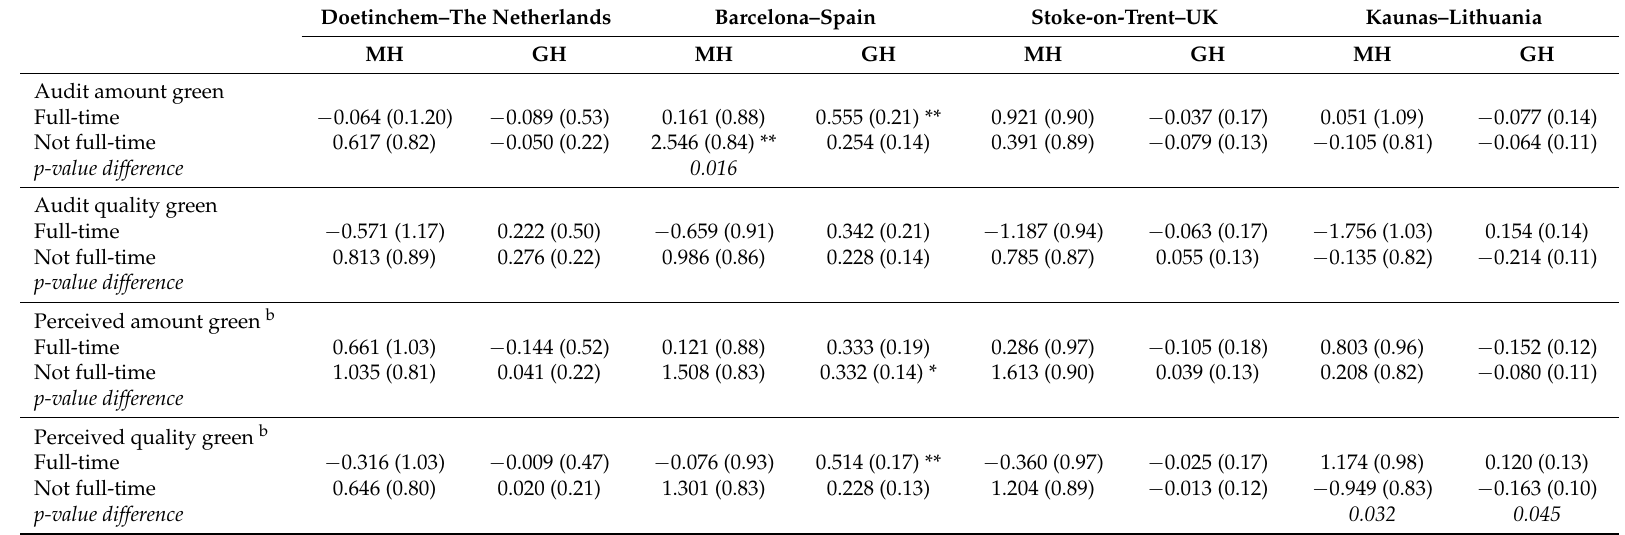
Table 5. Multilevel regression analysis for the relationship between neighbourhood green space (standardised estimates) and mental health (MH) and general health (GH) (standard errors in parentheses), by employment (for significant differences between subgroups the p -value is provided) a